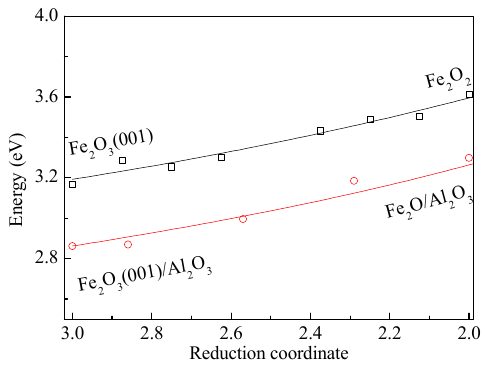
Figure 14. Energy required for removing O from the pure and reduced Fe 2 O 3 /Al 2 O 3 gradually into FeO/Al 2 O 3 , and Fe 2 O 3 (001) into FeO.